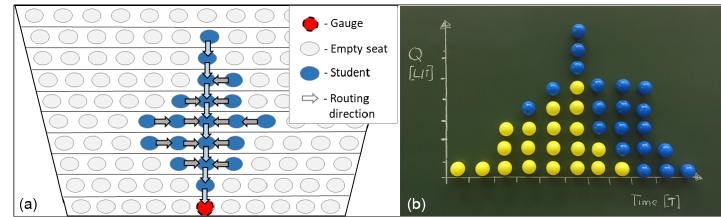
Figure 5. The superposition of two rainfall events, both producing an effective precipitation of 1mm. The first event is represented by yellow balls, the second event, which is delayed by four time steps, is represented by blue balls. Panel (a) illustrates the student seating and routing scheme applied in this experiment. The resulting hydrograph is shown in (b) .